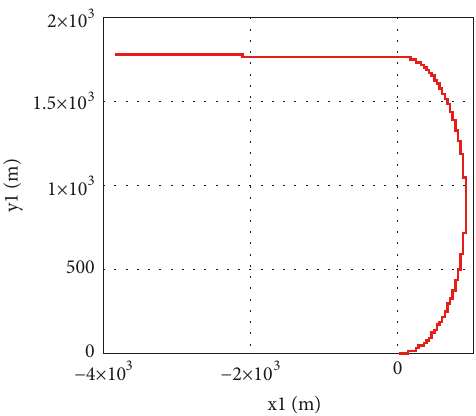
Figure 6: Vessel trajectory during rotation towards the return course for 𝑧 ∗ 3 = 0.005𝑟𝑎𝑑 ⋅ 𝑠 −1 , 𝑧 ∗ 6 = 3.14𝑟𝑎𝑑 .